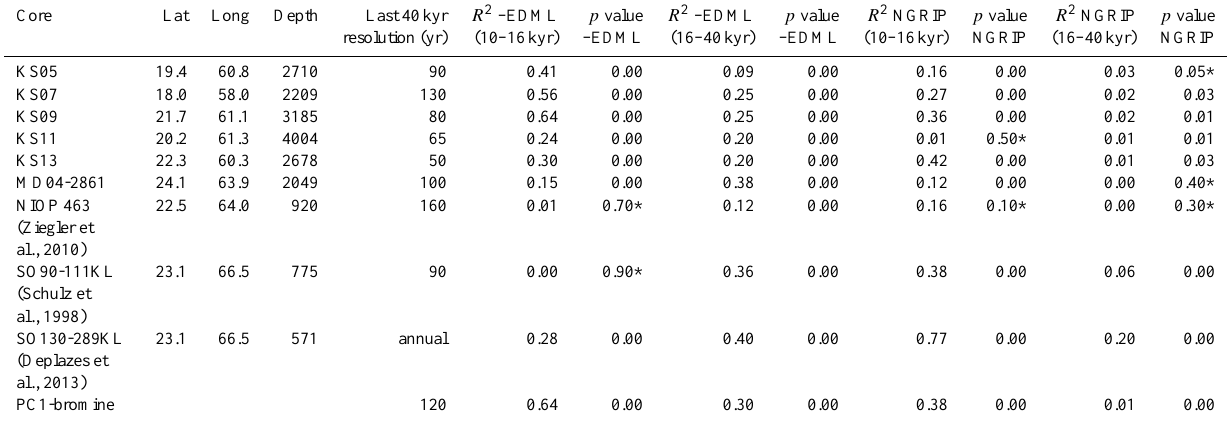
Table 2. Statistical tests with R software underlying the coefficient of determination R 2 and p value between productivity records of the Ara- bian Sea and bipolar climate records (NGRIP and –EDML δ 18 O ice) for the interval 10–16kyr and 16–40kyr. Asterisks refer to insignificant regressions between